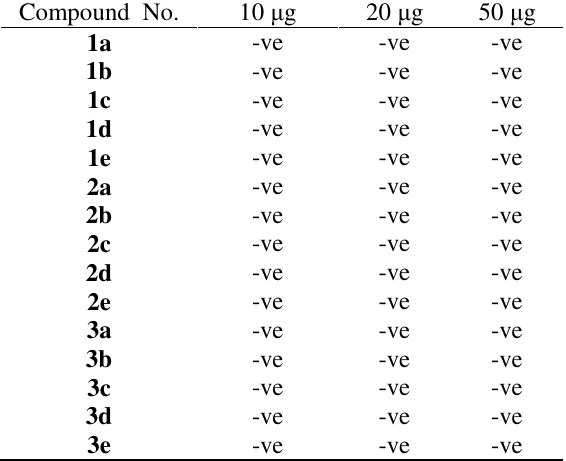
Table 2 . Antibacterial activity of compounds